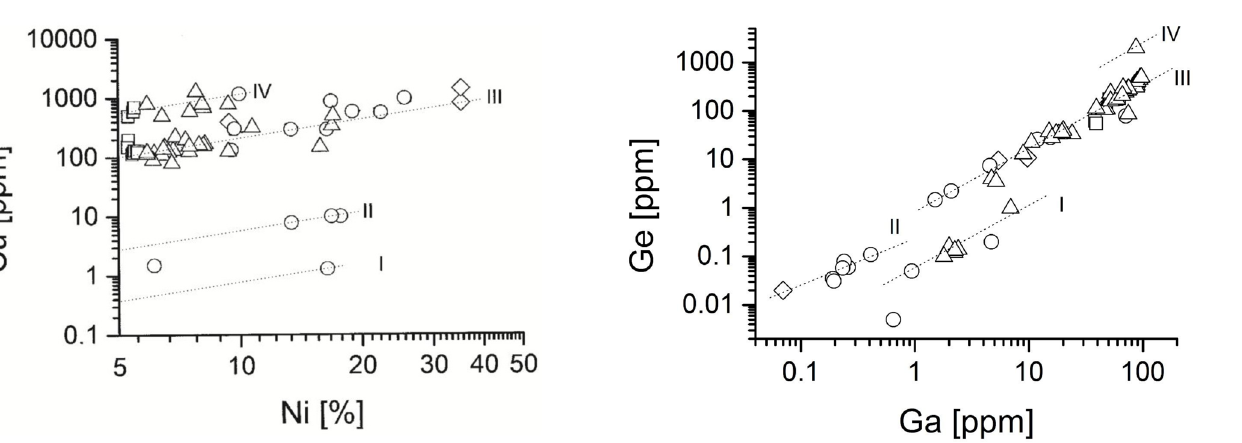
Figure 10. Logarithmic plot Ge against Ga for iron meteorites (data from Table 2); Δ octahedrites, o hexahedites, ¡ ataxites, ◊ anomalous; Group I: 1 ataxite and 5 Of with very low Ge/Ga ratio; Group II: 6 ataxites and 1 anomalous with low Ge/Ga ratio; Group III main group Ge/Ga ratio 0.8-5.1 with 7 ataxites, 2 anomalous, 1 Off, 2 Of, 8 Om, 9 H, 2 O plessitic , 14 Og, 7 Ogg; Group IV: O plessitic